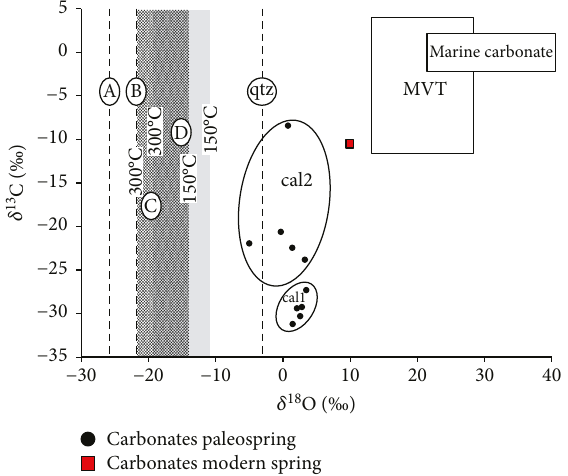
Figure 11: Plot of stable C ( ‰ , relative to VPDB) and O ( ‰ , relative to VSMOW) isotope data for carbonates (cal1 and cal2) from paleospring hydrothermal veins (black circles) and modern carbonate precipitate (red square). Line A is the O isotope composition of meteoric water in the study area (constrained using lat-long-elevation data; using the OIPC3.1 calculator, University of Utah). Line B is the composition of water that would be in equilibrium with modern carbonate at the springs at a mean temperature of 6 ° C. Fields “ C ” and “ D ” are the predicted compositional ranges for carbonates and quartz, respectively, expected if the paleospring hydrothermal veins crystallized at T between 150 and 300 ° C from meteoric water (based on T values h from fl uid inclusions and utilizing fractionation expressions from [140], [calcite-H O], [141] [aragonite-H O], and [142] [quartz- 2 2 H 2